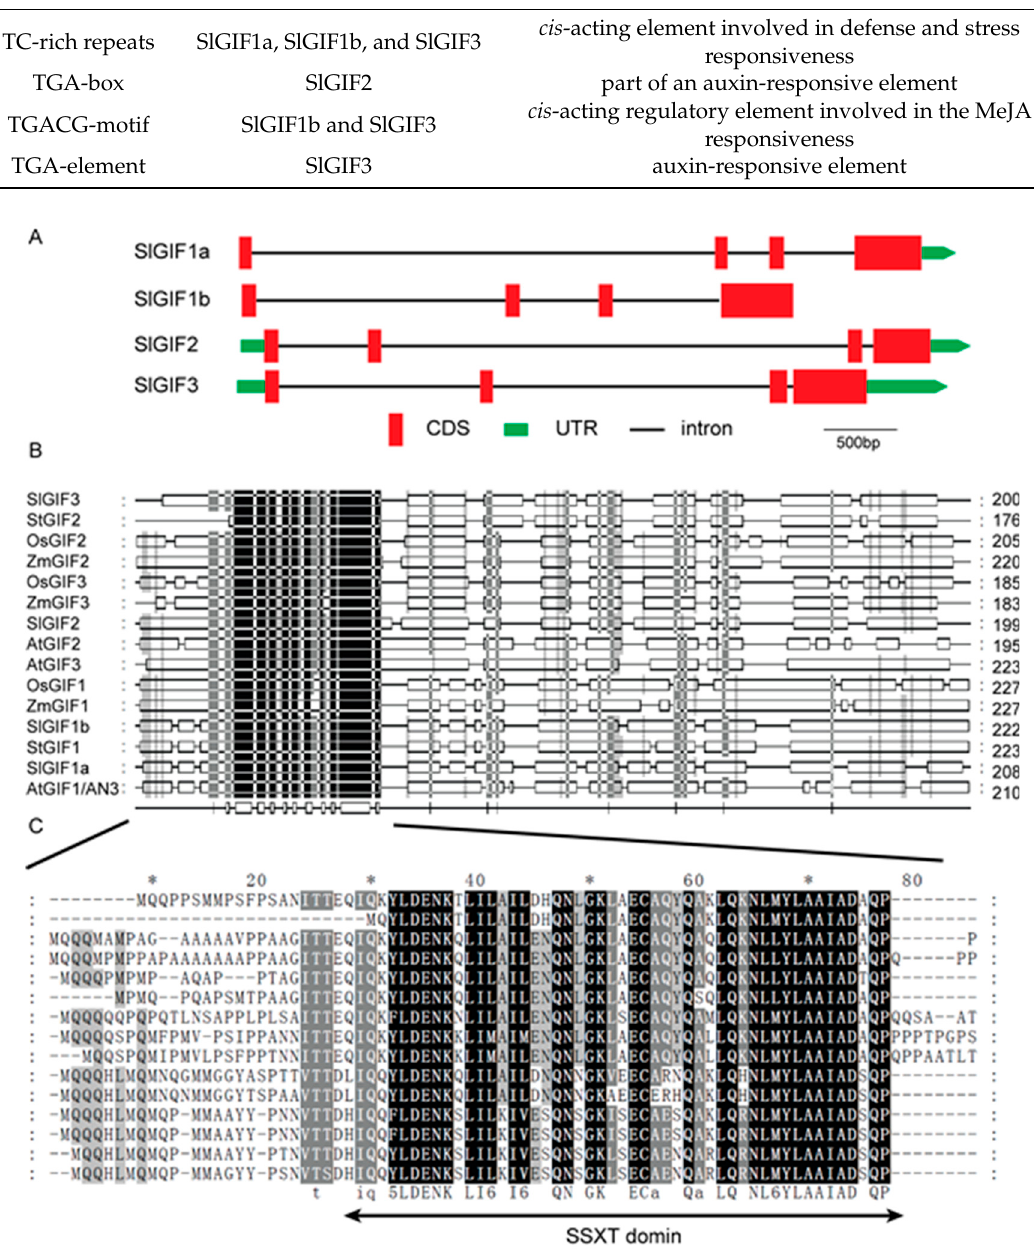
Figure 2. Structure and conserved motif analysis of the GIF genes. ( A ) The exon and intron structures of the tomato GIF genes. The gene structures of the SlGIF genes were illustrated using the Gene Structure Display Server (http: // gsds.cbi.pku.edu.cn / ) and the IBS software [41]. The red box and the green box represent the CDS and UTR, respectively. The solid line stands for the intron. ( B ) Motif analysis of the SlGIF proteins. The conserved motifs of all GIF proteins in this study were identified using ClustalX and GeneDoc software. ( C ) Detailed SSXT domains from the GIF proteins.